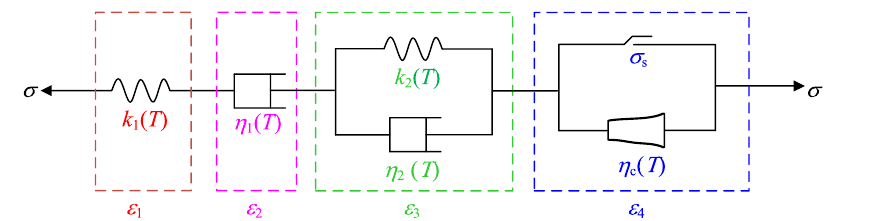
Figure 3. Nonlinear creep